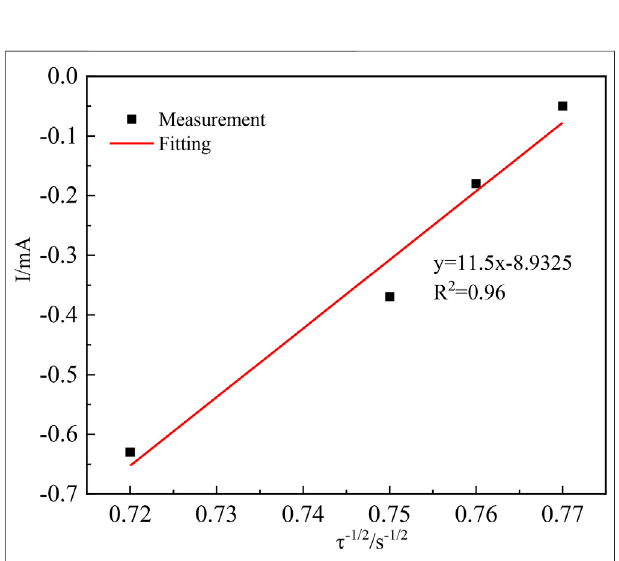
FIGURE 6 | Relationship between the current intensity I(t) and the negative square root of the transition time ( τ − 1/2